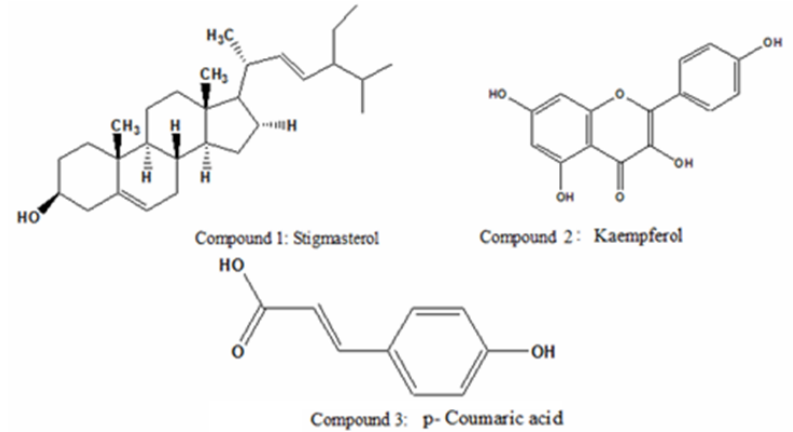
Figure 1, Isolated compound of Hydrolea zeylanica